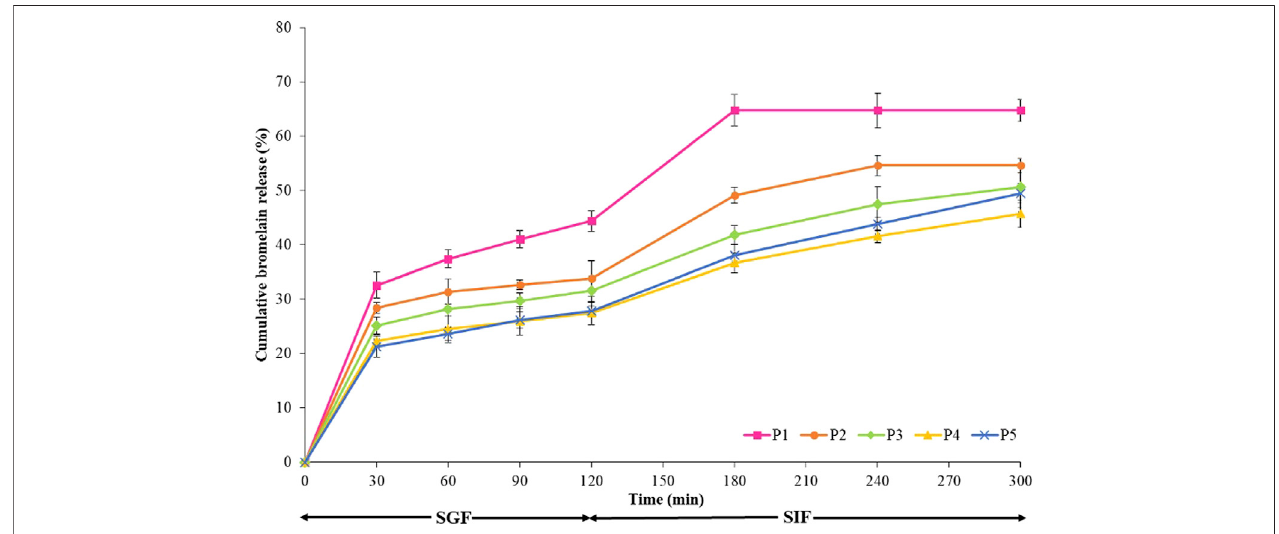
FIGURE7| Bromelainreleasebehaviorofthehydrogelbeadsinthesimulatedgastric fl uid(SGF)for2 handinsimulatedintestinal fl uid(SIF)for3 hat37 ° Cwithastir rate of 100 rpm.